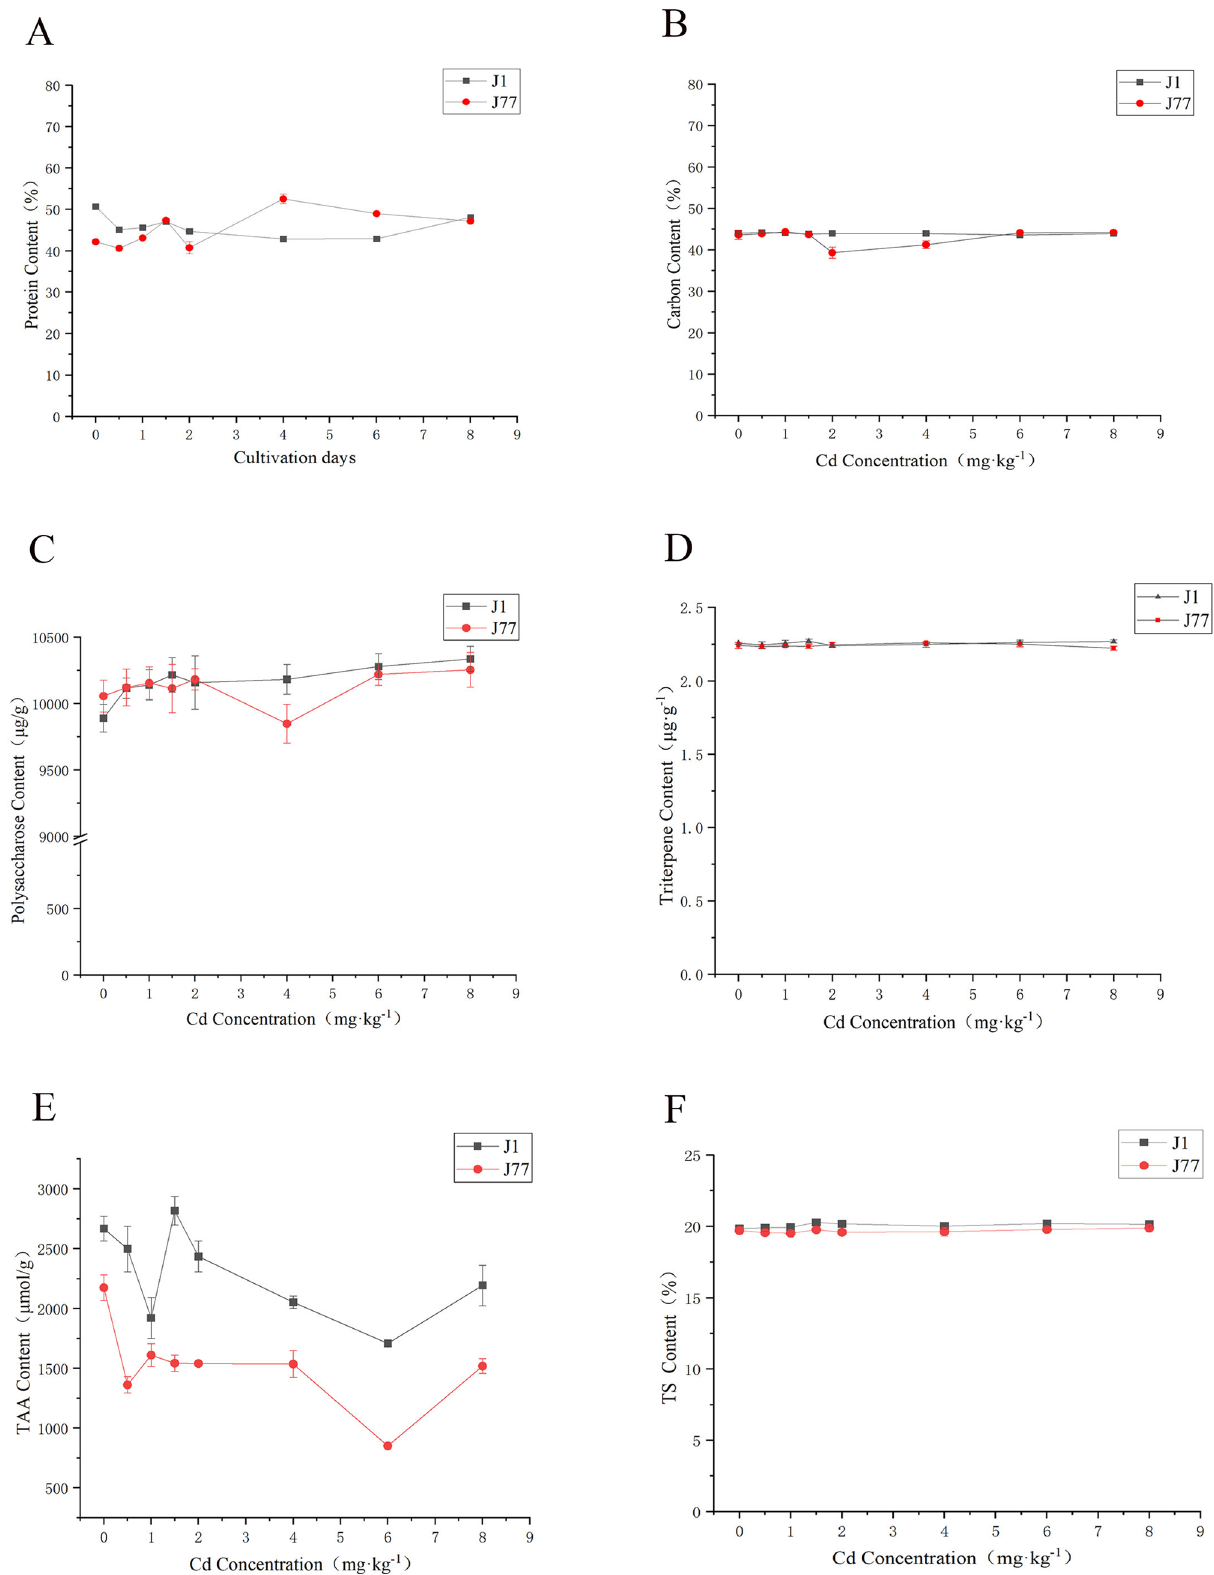
Figure 5. Effects of cadmium stress on nutrients in fruiting bodies A, B, C, D, E and F represent the protein, carbon, polysaccharide, triterpene, total amino acid and total sugar content in fruiting bodies of J1 and J77under different concentrations of Cd stress,